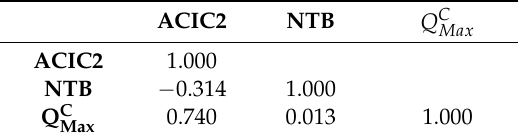
Table 3. Correlation matrix of the 3 descriptors used in the model.